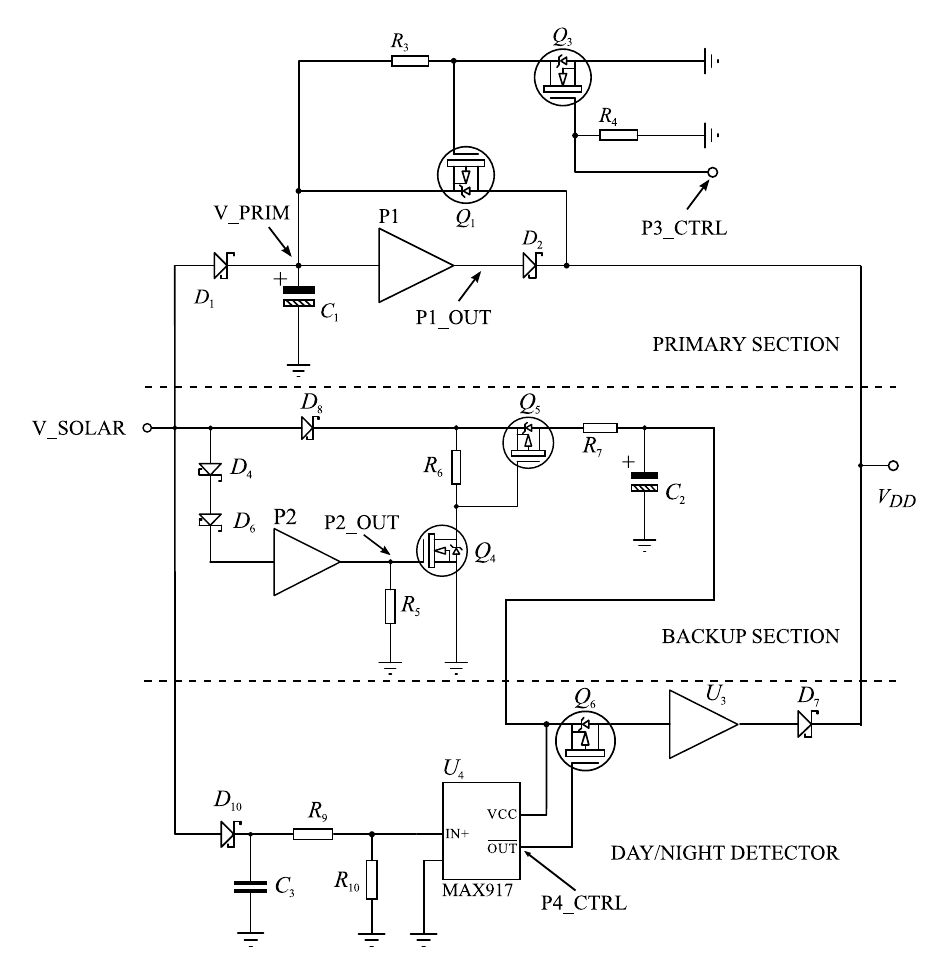
Figure 3. Schematic of the harvesting